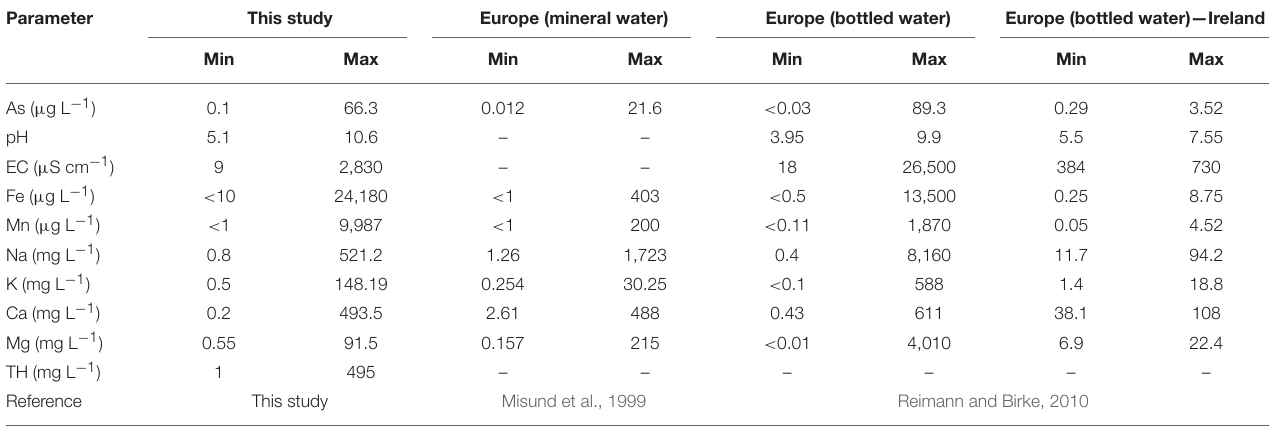
TABLE 5 | Comparison of arsenic within European regions.